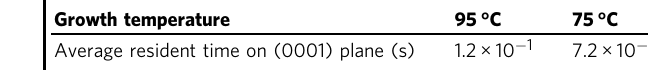
-- 11 Þ plane in vacuum and water